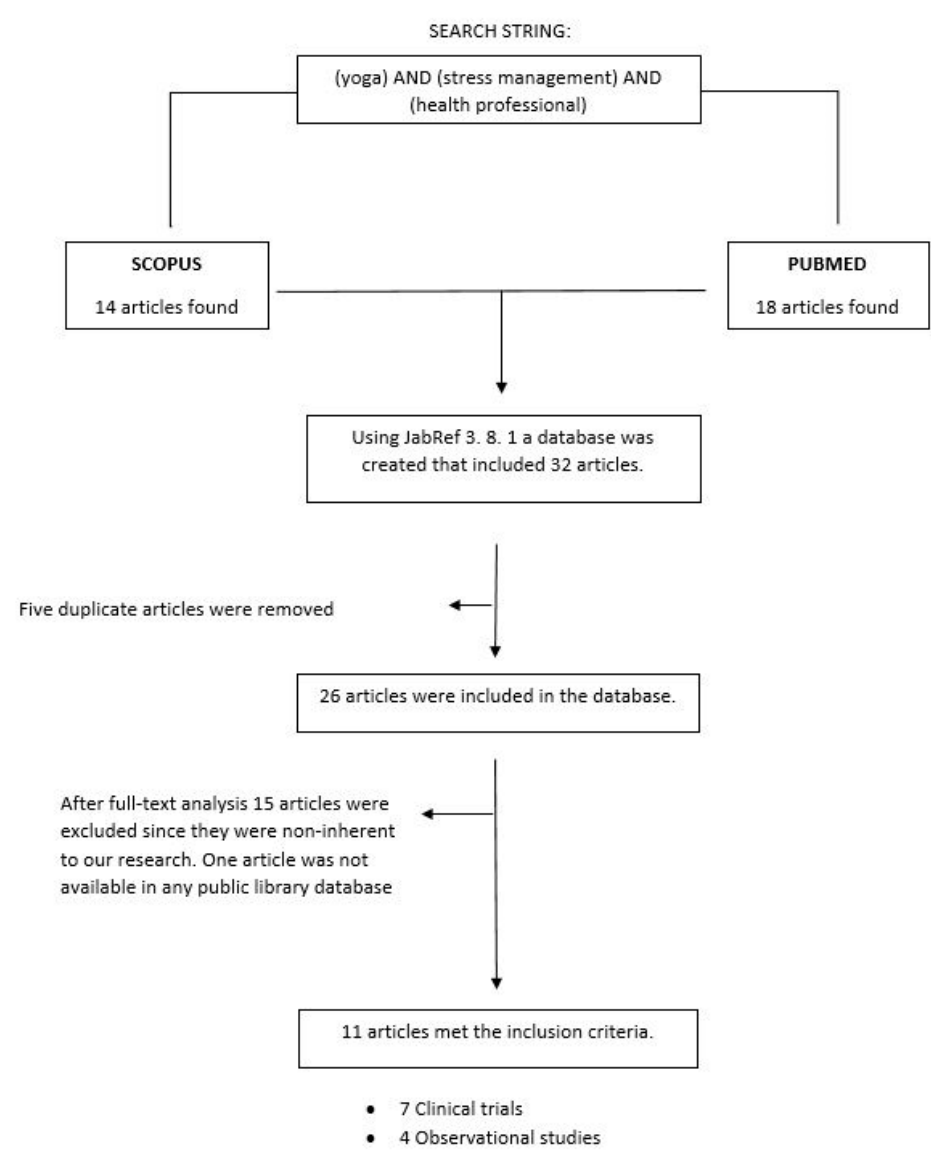
Figure 1. Research flowchart displaying selection and analysis of the items included in the systematic